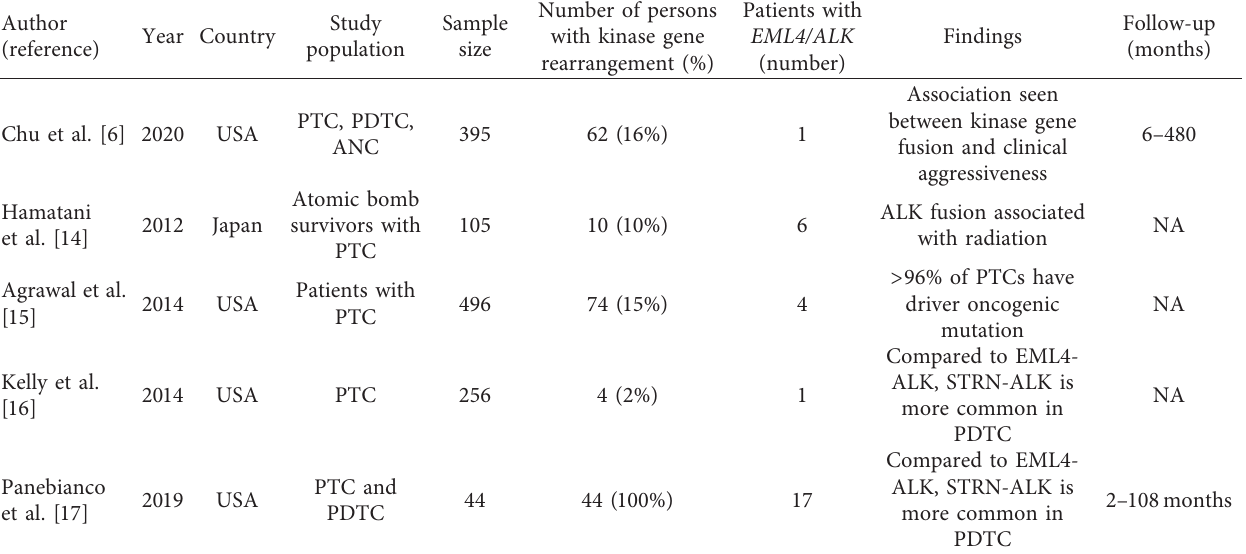
Table 1: Prevalence of EML4/ALK